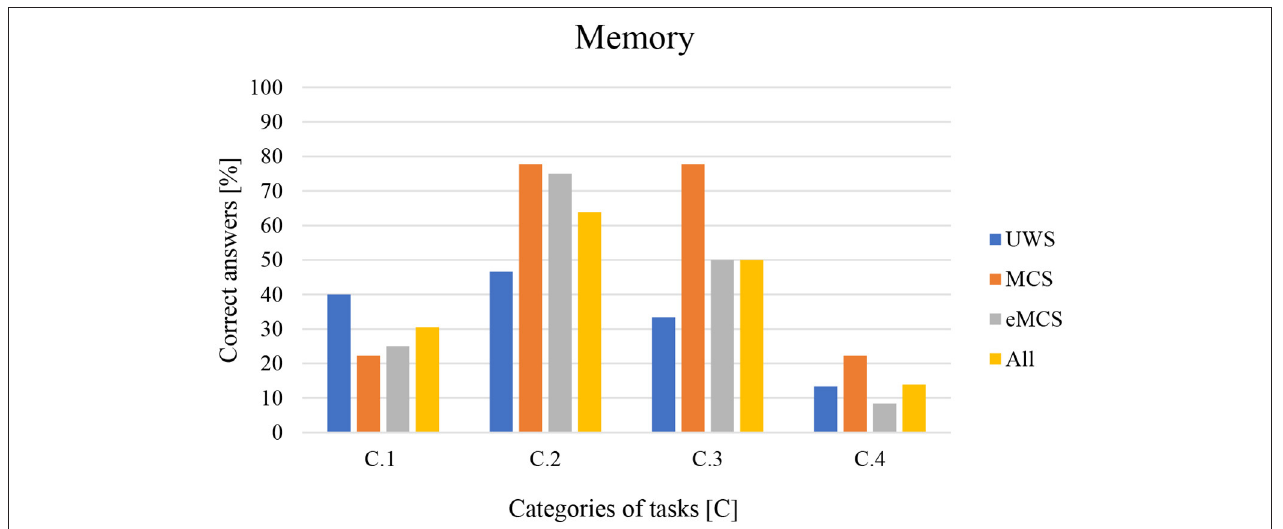
FIGURE 3 | Percentage of correct answers in the tasks by C.1–C.4 category. C.1—memory for visual material, C.2—semantic memory, C.3—orientation to time, and C.4—working